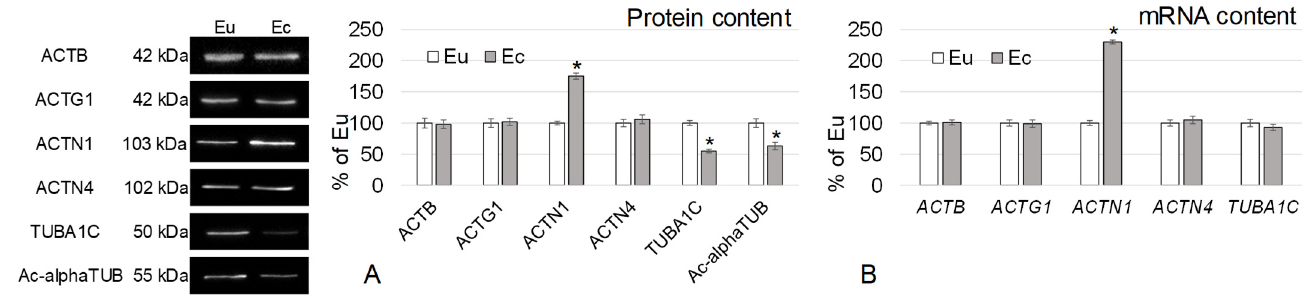
Figure 2. The relative cytoskeletal protein content ( A ) with Western-blots and mRNA content ( B ) in the eutopic and ectopic endometrium. Eu—eutopic endometrium. Ec—ectopic endometrium.